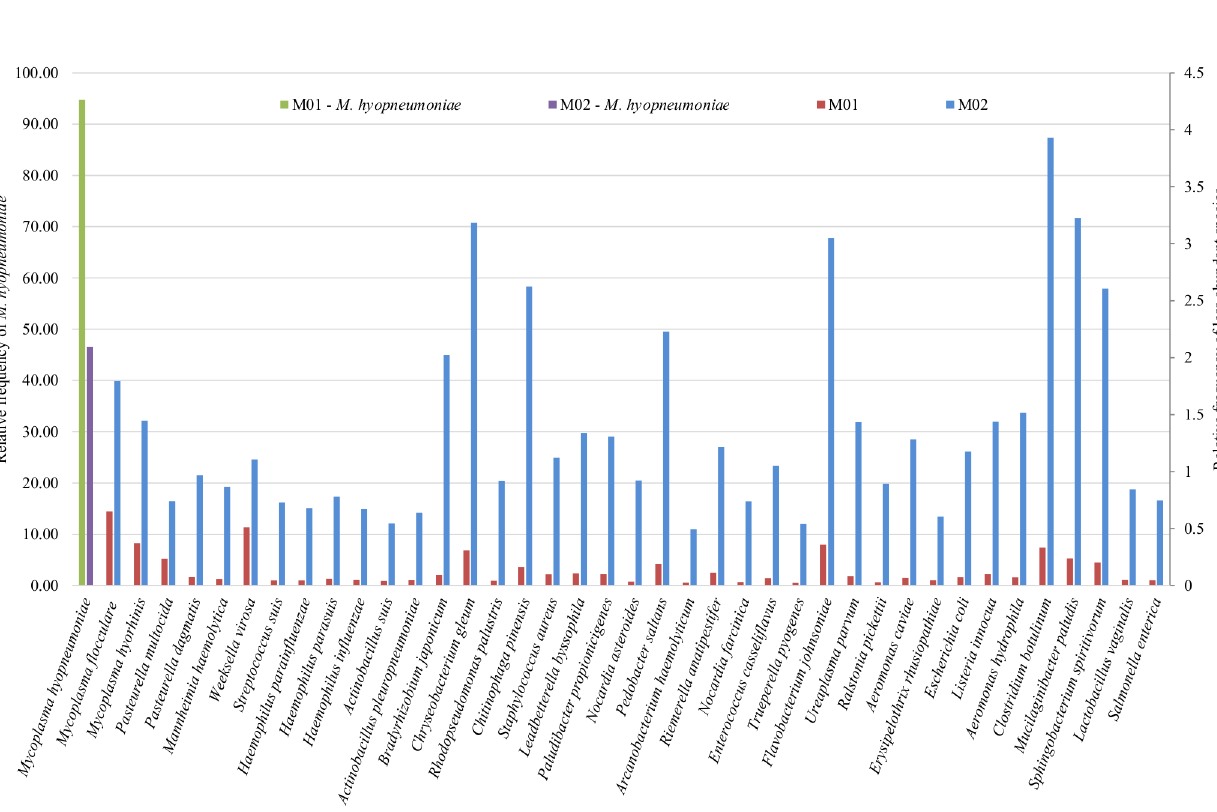
PLOS ONE | https://doi.org/10.1371/journal.pone.0181503 July 18,